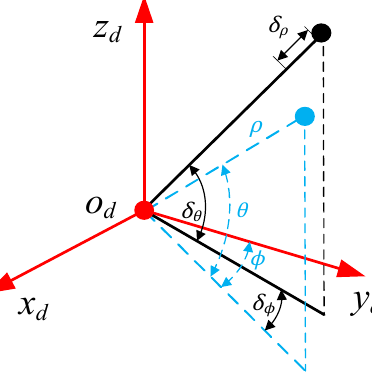
Figure 2. Schematic diagram of LiDAR ranging system.